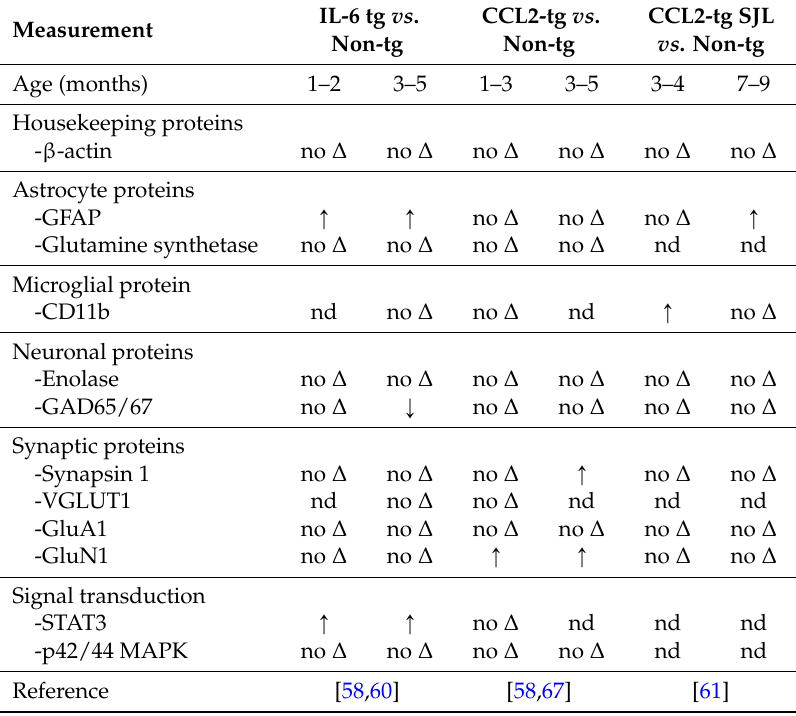
Table 3. Genotypic differences on protein levels in